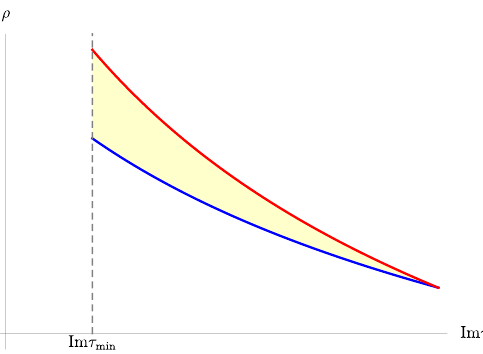
Figure 2 . Region of validity of the EFT speci(cid:12)ed by